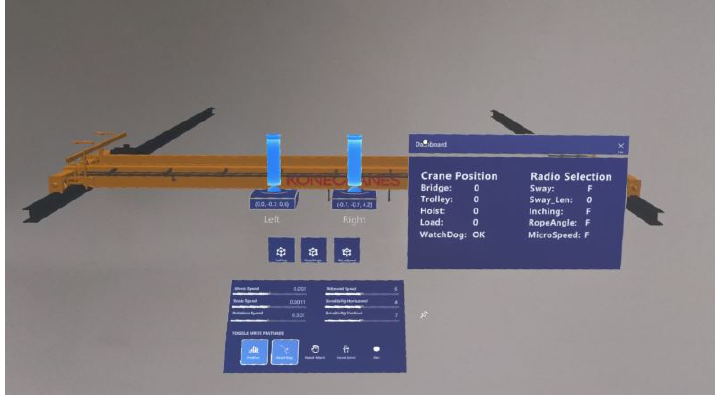
Figure 12. The screenshot of the MR application in HoloLens